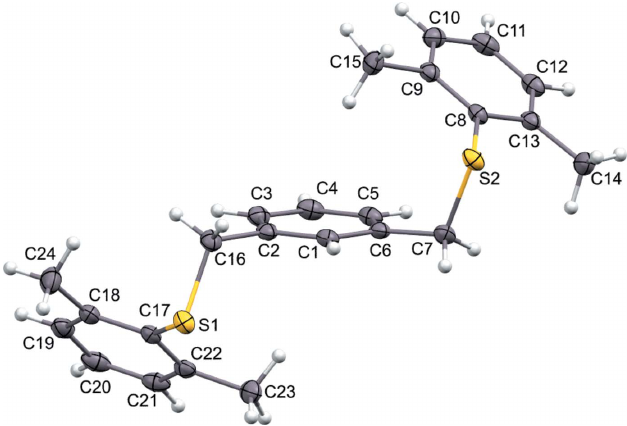
Figure 1 The molecular structure of the title compound with displacement ellipsoids drawn at the 50% probability level.